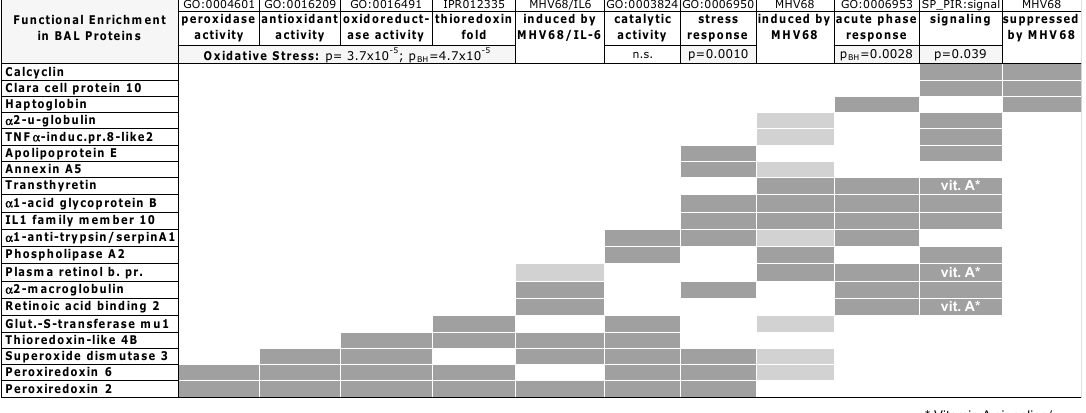
Figure 3. Functional enrichment matrix for identified BAL proteins. Protein functional enrichment for 20 out of 23 BAL proteins identified, clustered by Gene Ontology (GO), InterPro (IPR), and Protein Information Resource (SP_PIR) term annotation, Ingenuity Pathways Analysis (IPA), or regulation by WT MHV-68 (MHV68) and MHV68/IL6 (infex). Dark gray, inclusion in functional term or strong regulation. Light gray, weak induction by MHV-68 or MHV68/IL6. Proteins involved in vitamin A (vit. A *) signaling and transport were enriched within the signaling category with p = 0.0094. Significance estimated by p -values ( labeled p) for enrichment in annotated functional categories; Benjamini–Hochberg (p BH ) false discovery probability values for IPA category analysis. n.s. = not significant.